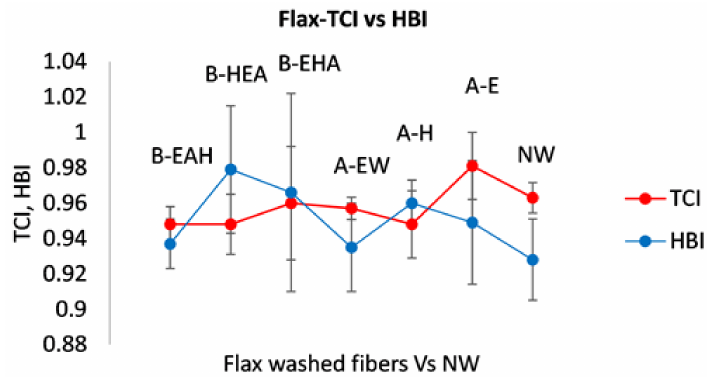
Figure 7. Crystallinity indexes (TCI vs. HBI) of flax fibers with standard